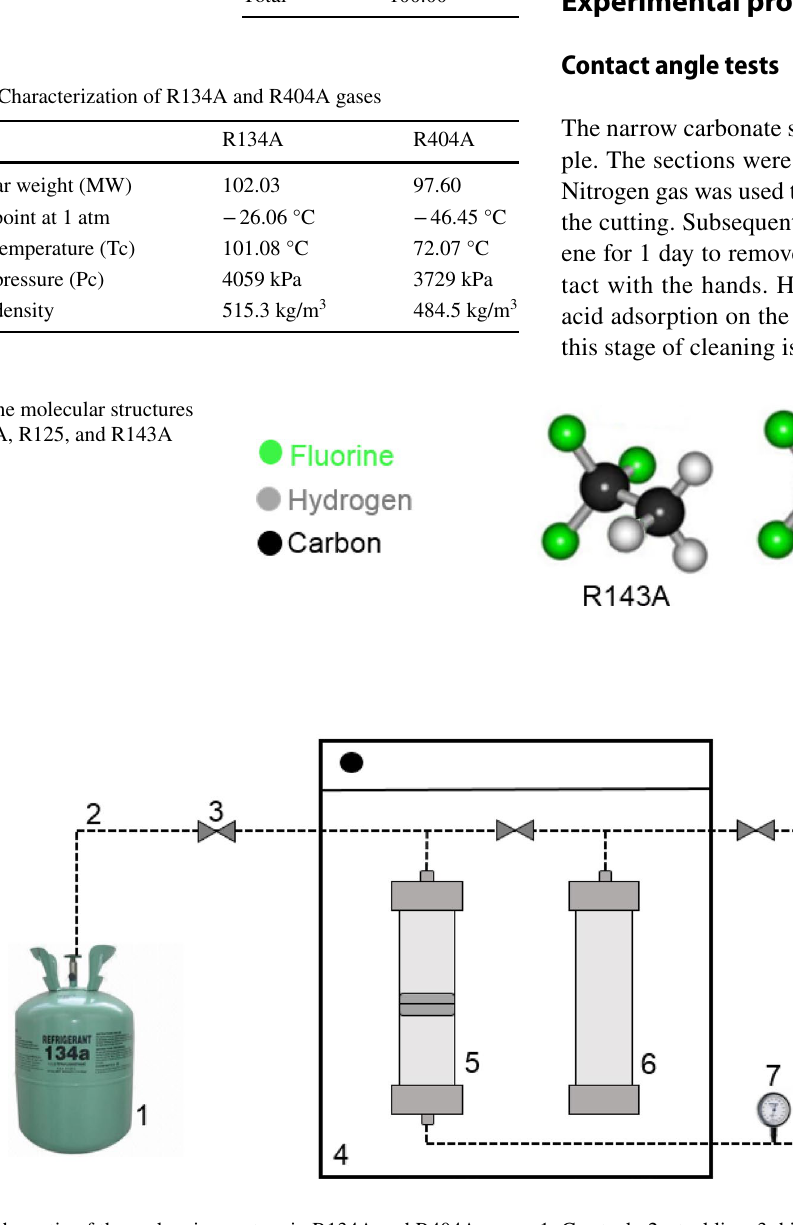
Fig. 3 Schematic of the rock aging system in R134A and R404A gases. 1: Gas tank, 2: steel line, 3: high-pressure valve, 4: oven, 5: cylinder and movable piston, 6: aging chamber, 7: pressure gauge, 8: vacuum pump, 9: manual hydraulic